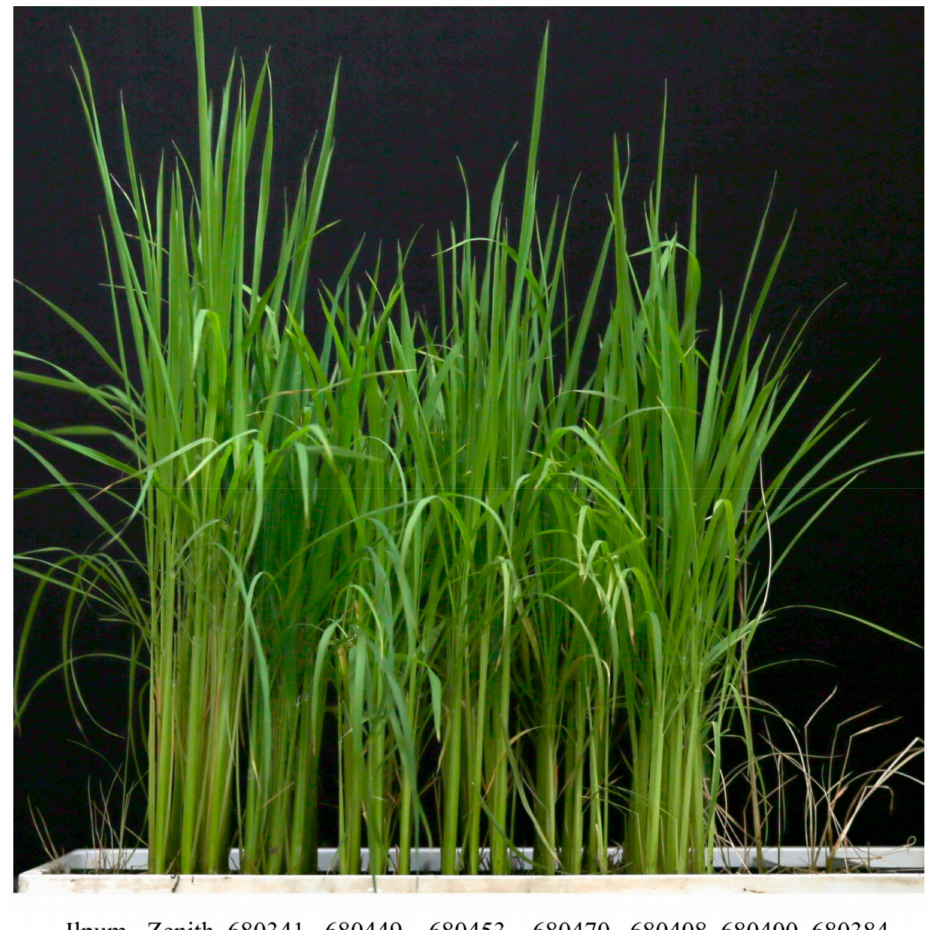
Figure 5. Phenotypic responses to bakanae disease infection in seven homozygous recombinants for secondary